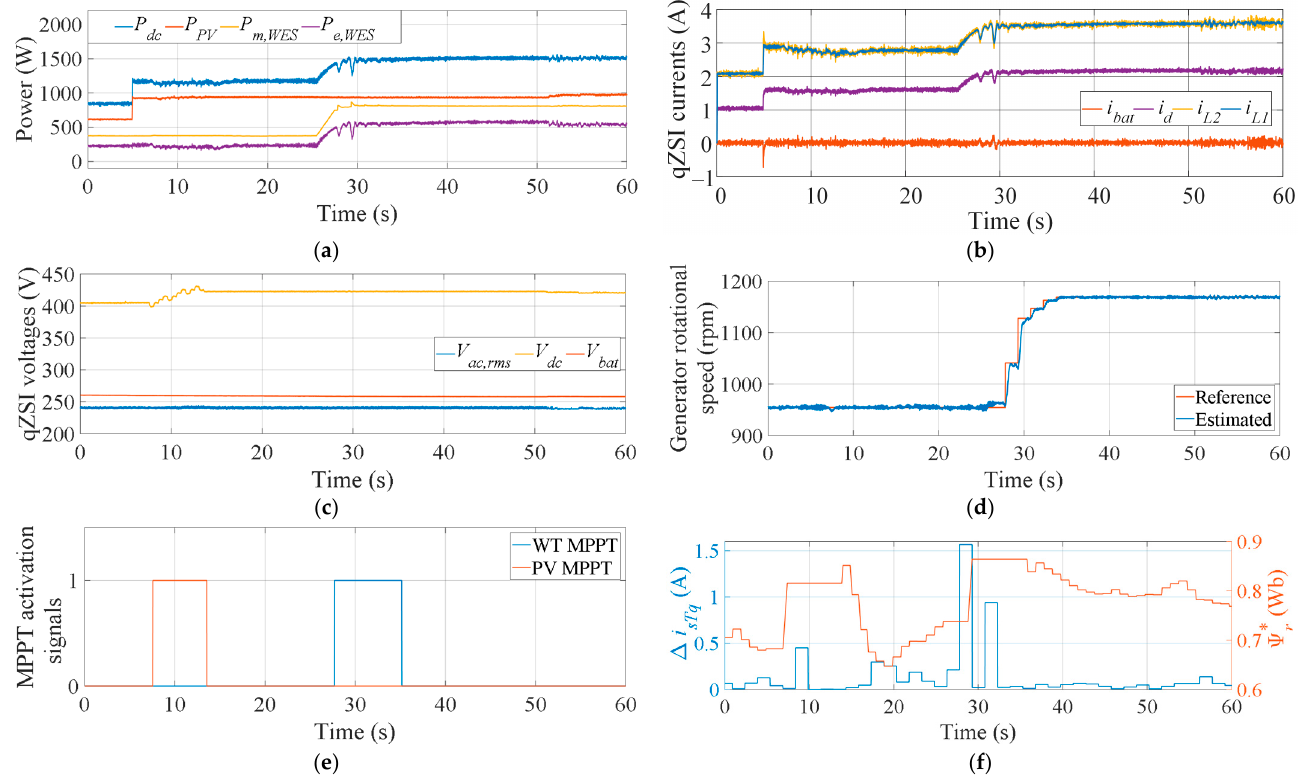
Figure 19. Dynamic responses to load, irradiance, and wind speed changes in the selected time interval (0–60 s): ( a ) electrical power and WT mechanical power; ( b ) qZSI currents; ( c ) qZSI voltages; ( d ) generator rotational speed; ( e ) MPPT algorithms activation signals; ( f ) SCIG torque-related current change and rotor flux reference value.